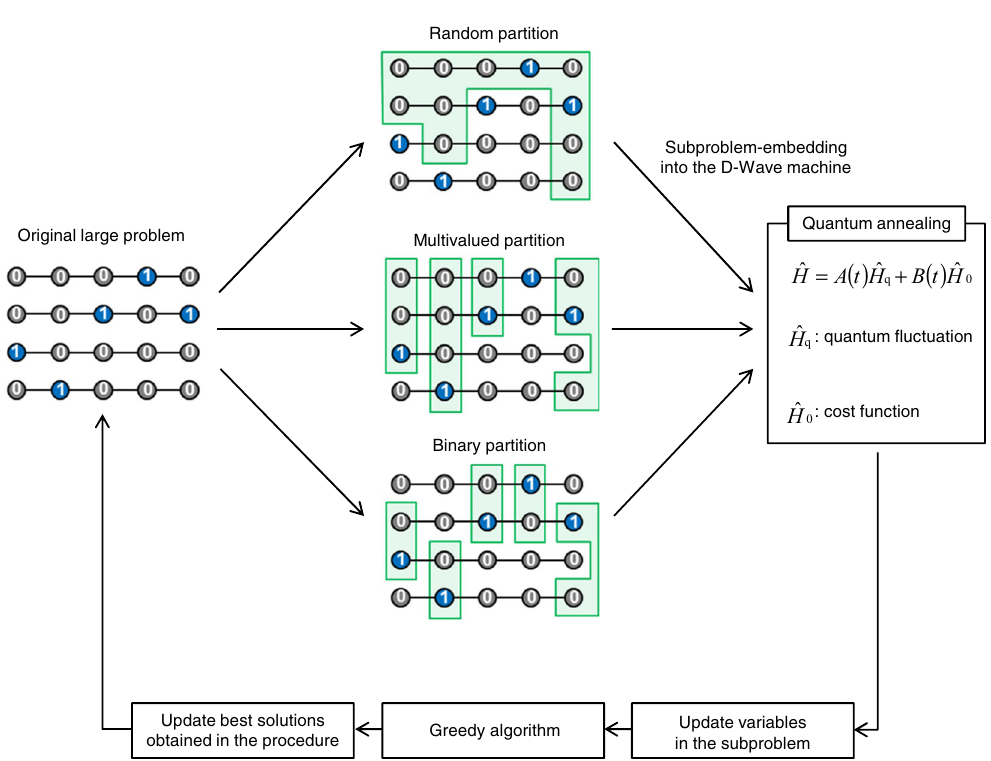
Figure 4. Optimization process demonstrated in this study. The solution accuracy is evaluated for the three partitioning